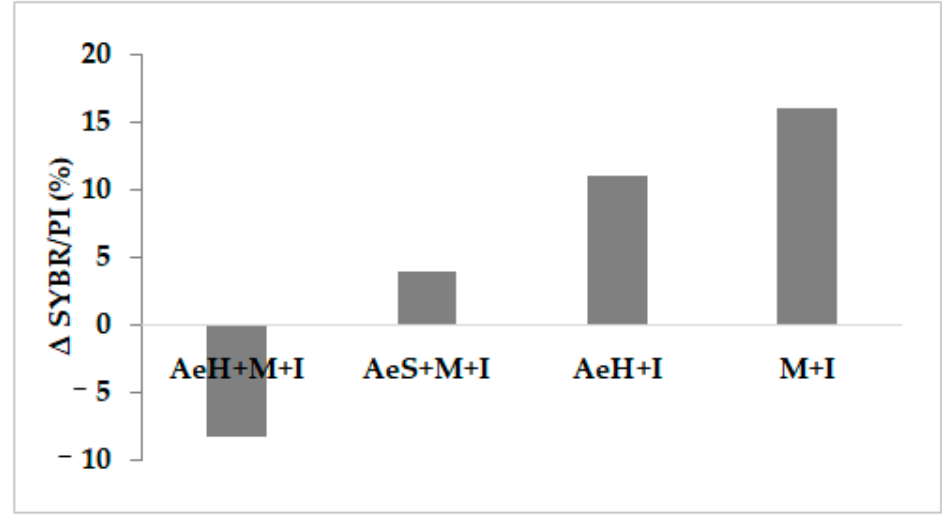
Figure 3. Δ SYBR/PI calculated for all the